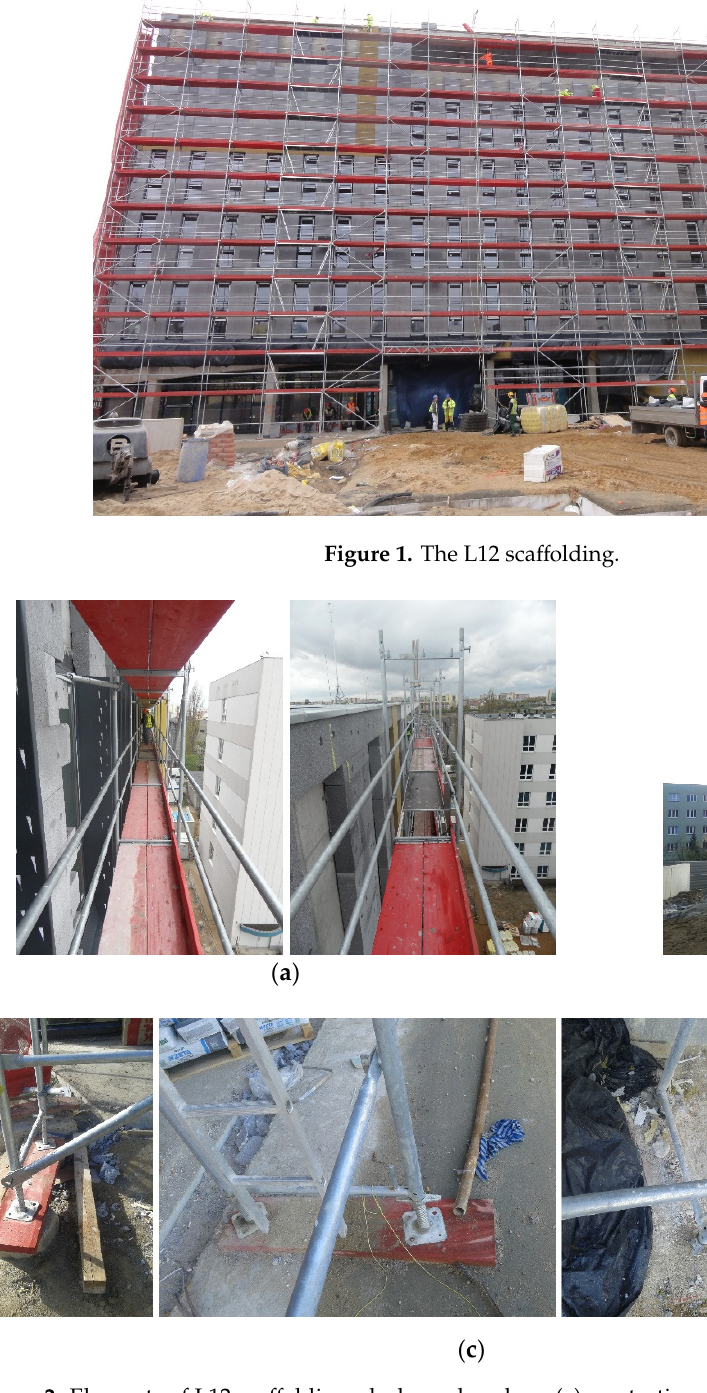
Figure 2. Elements of L12 scaffolding: decks and anchors ( a ); protective roof ( b ); mudsills (only the second frame is set correctly) ( c ).